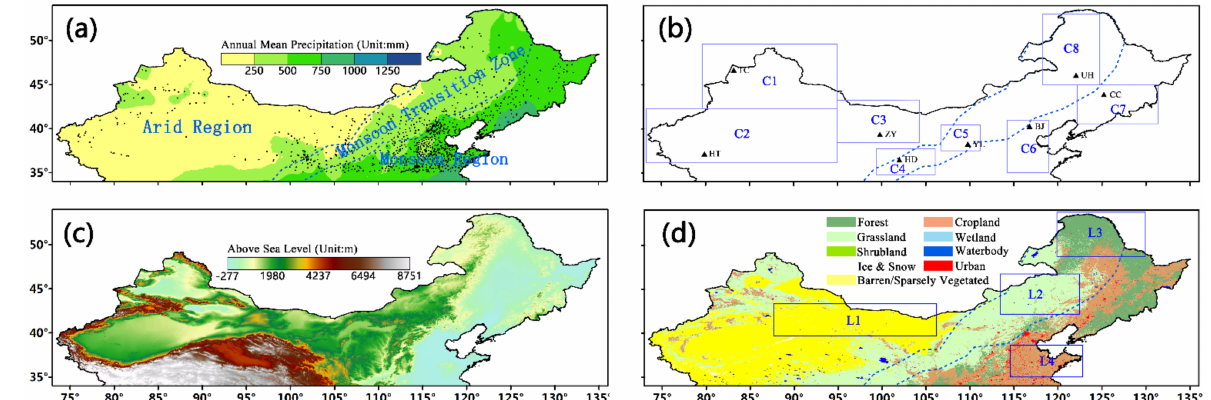
Figure 1. ( a ) Climate zones (separated by blue dashed lines) and in situ sites (black dots) in the study area. ( b ) Eight typical areas (blue rectangles) and the corresponding representative stations (black triangles). The zones C1 to C8 respectively represent northern Xinjiang, southern Xinjiang, Hexi Corridor, Qinghai–Tibet Plateau Slope, northern Loess Plateau, North China Plain, eastern Northeast Plain, and western Northeast Plain. The information of the representative stations is listed in Table 1. ( c ) The topography of the study area. ( d ) The distribution of vegetation type, with blue rectangles denoting different types: L1 as the Gobi desert, L2 as the grassland, L3 as the for-est, and L4 as the